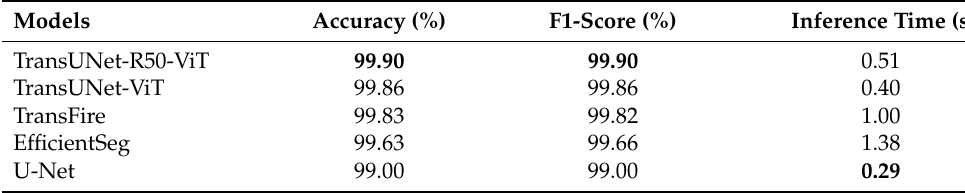
Figure 9. Results of TransFire, TransUNet-R50-ViT, and EfficientSeg. From top to bottom: RGB aerial images and the results of TransFire, TransUNet-R50-ViT, and EfficientSeg. Orange represents TP , yellow depicts FP , and red shows FN . We can see the interesting results of TransFire in determining the precise size of small wildfire areas under the presence of smoke compared to TransUNet and EfficientSeg models. Table 6. Performance evaluation of wildfire segmentation